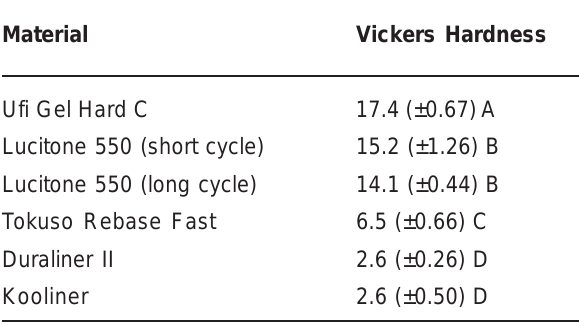
The same uppercase letter in a column represents values that were not significantly different at p =0.05.